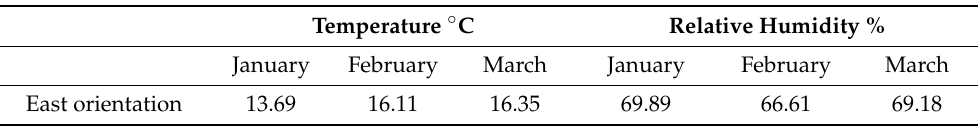
Table 2. Calculated data for calibration and validation of the model. Average monthly values for temperature and humidity.